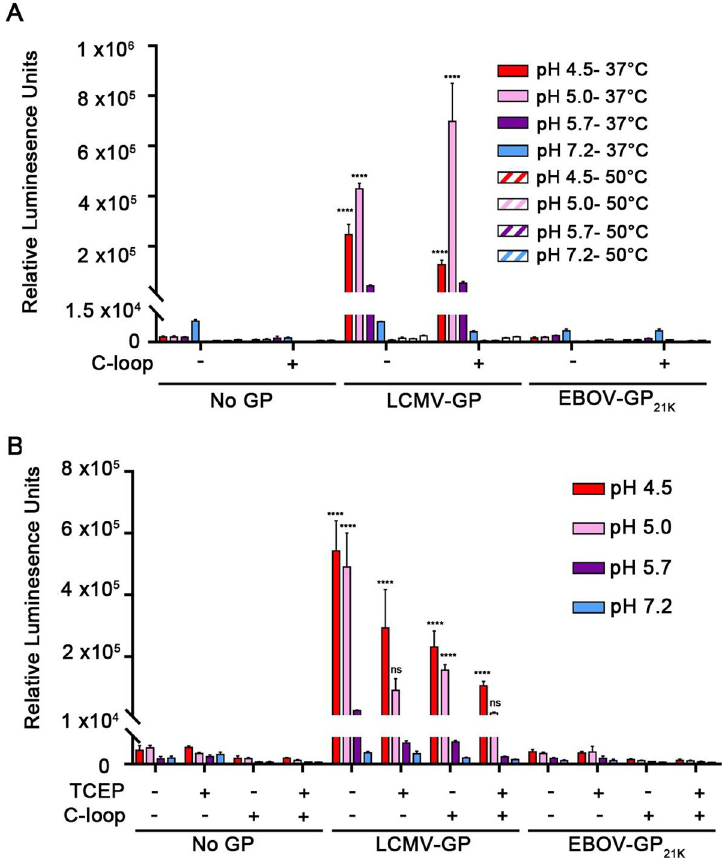
Fig 3. Elevated temperature and reducing conditions do not trigger detectable fusion between cells expressing EBOV-GP cl and cells expressing NPC1 C-loop. (A) Target and effector HEK293T/17 cells were prepared, treated and analyzed for CCF, as described in the legend to Fig 1A except that the pH pulse was done at either 37˚C or 50˚C, as indicated. ( B ) Cells were prepared, treated and analyzed as in panel A except that, where indicated, the fusion buffer contained 5 mM TCEP. Results represent mean +/- SD of triplicate samples from one of two experiments with similar results. Statistical analyses are based on two-way ANOVA tests; each sample was compared to the respective No GP sample ���� p <